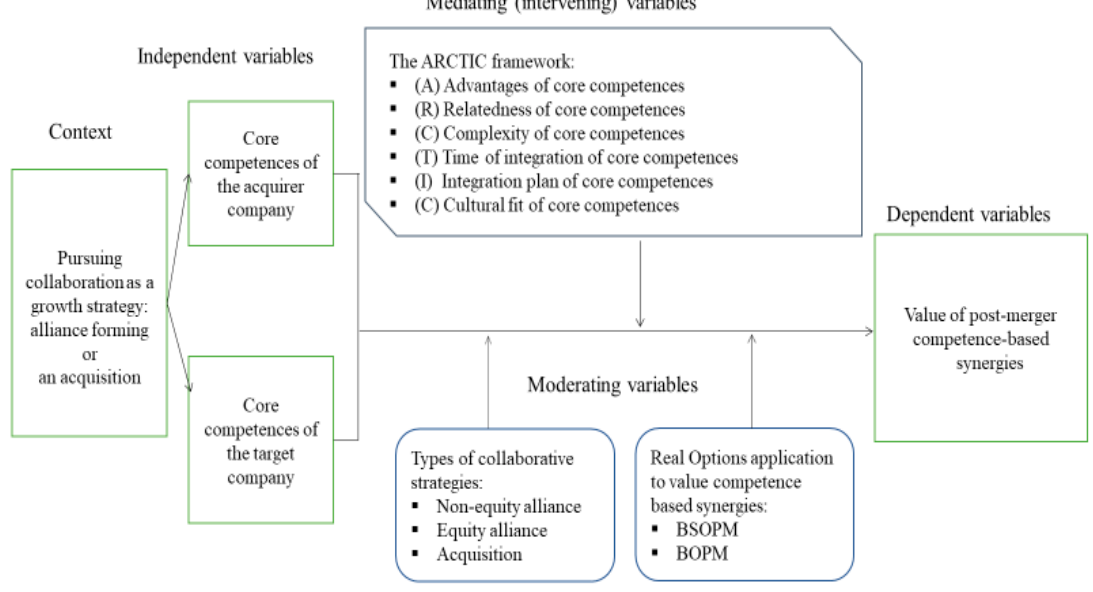
Figure 1. The theoretical framework of the current research.